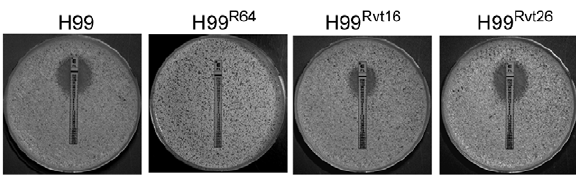
Figure 1. FLC E-tests. Approximately 1 6 10 6 cells of each strain were plated on YPD media and E-test strips were placed on the media. The plates were incubated at 30 u C for 72 h. Strains: H99 (wild type), H99 R64 (resistant at 64 m g/ml of FLC), H99 Rvt16 , and H99 Rvt26 (H99 R64 derivatives obtained by daily transfer of H99 R64 on drug-free media for 16 and 26 days,